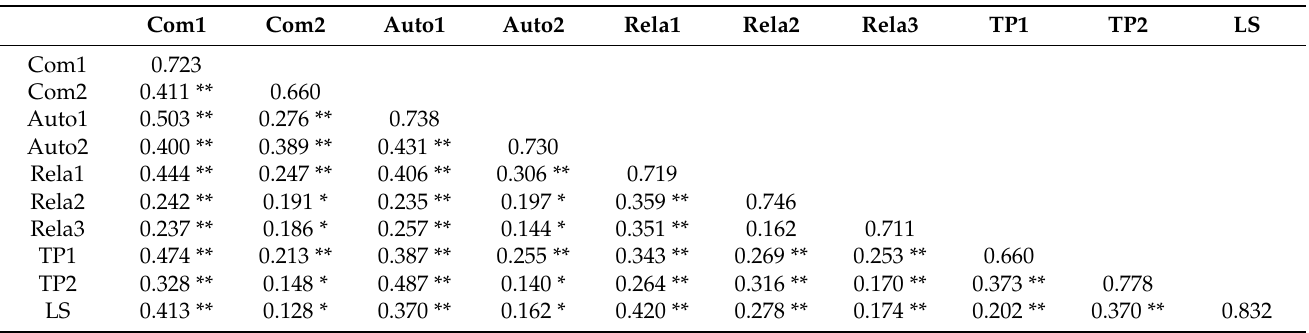
Table 3. Discriminant Validity Test Results of First Order